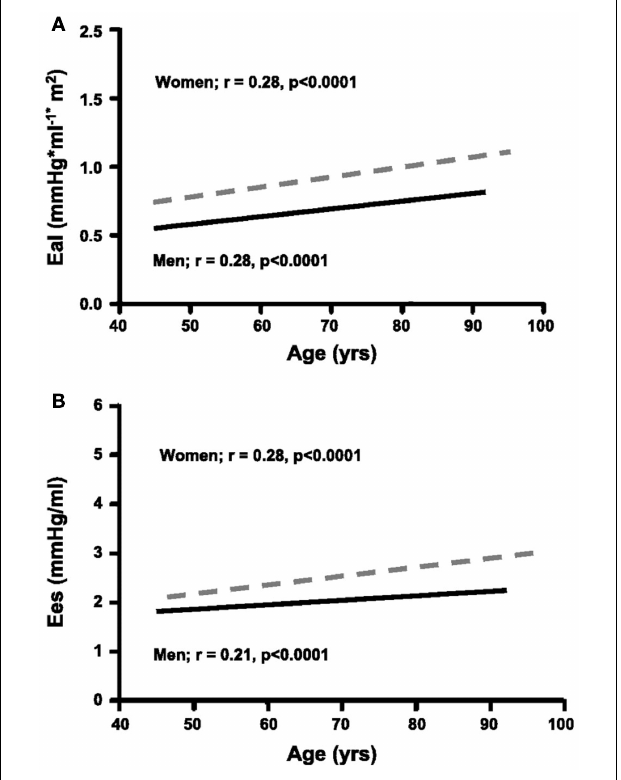
FIGURE 3 |The association between age and E A indexed to body surface area (E A I) (A) and E LV (E es = E LV ) (B) in men (solid line) and women (dashed line) at rest. Pearson correlation coefficients and probability values for each association are shown.With advancing age, both E A I and E es increase. However, the increase in E es with age is significantly greater in women than men. Furthermore, E A I and E es are higher in women vs. men at all ages. Modified from Redfield et al. (2005) with